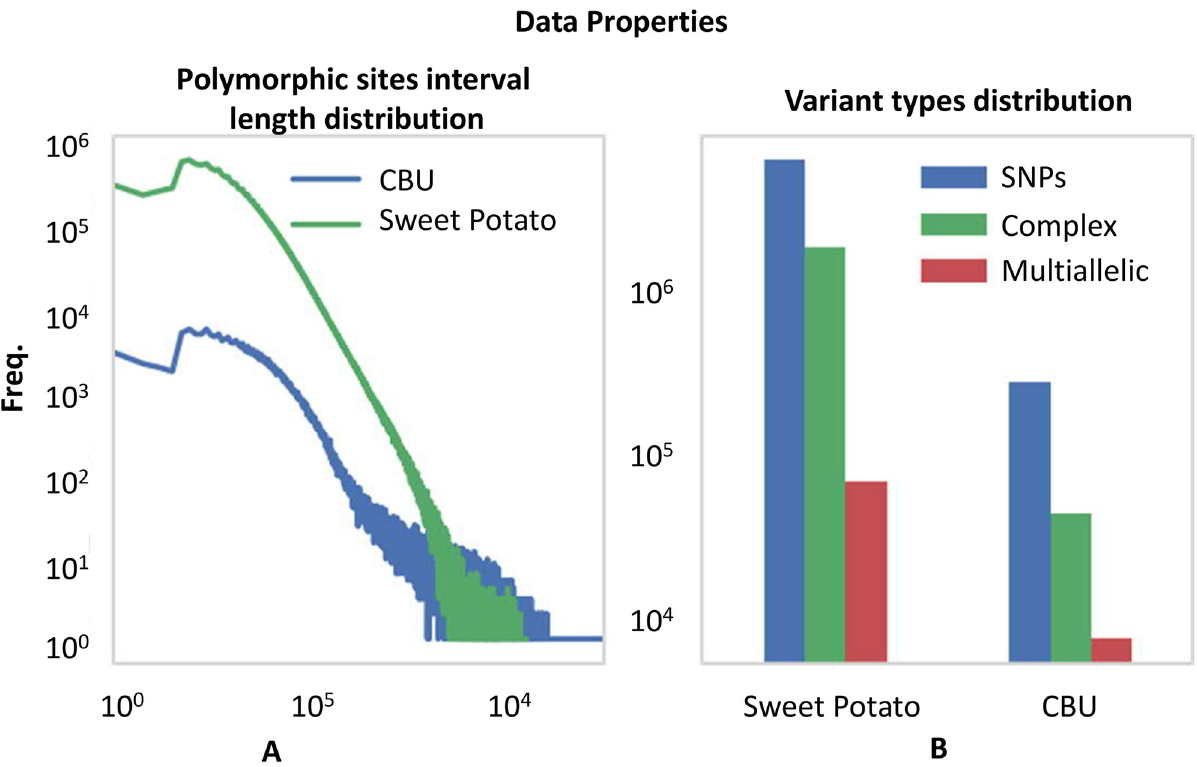
Fig 3. Properties of the sweet potato and CBU genome datasets. (A) The interval length distribution of polymorphic sites. Both axes are in log scale. (B) The frequencies of different types of variants. The y-axis is in logarithmic scale.